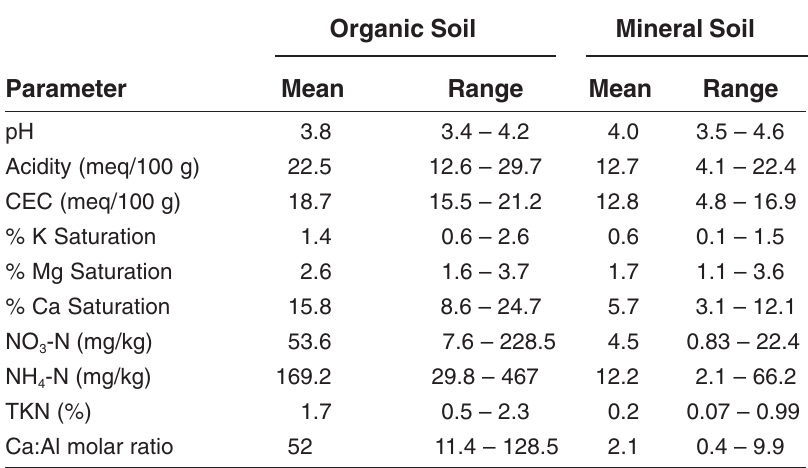
Chemical Characteristics of Soils on the Baldwin Creek